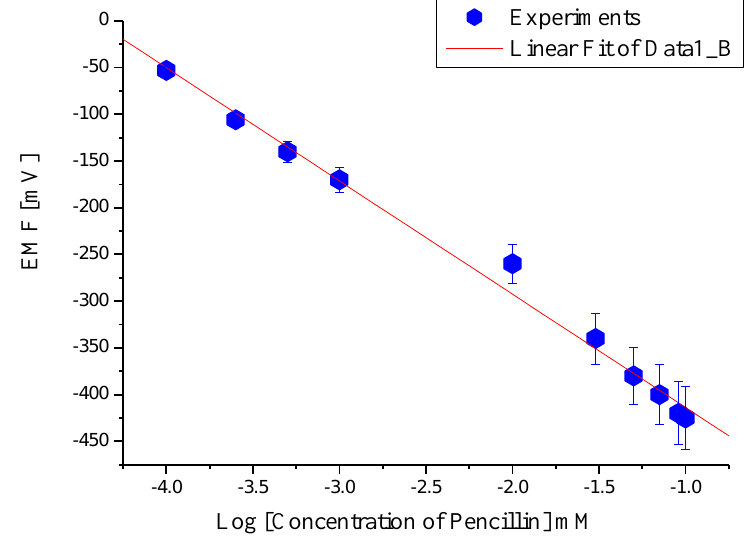
Figure 2. Calibration curve of the immobilized ZnO-nanorods based sensor electrode showing the electrochemical response (EMF) at various penicillin salt concentrations (100 µM to 100 mM) with Ag/AgCl reference